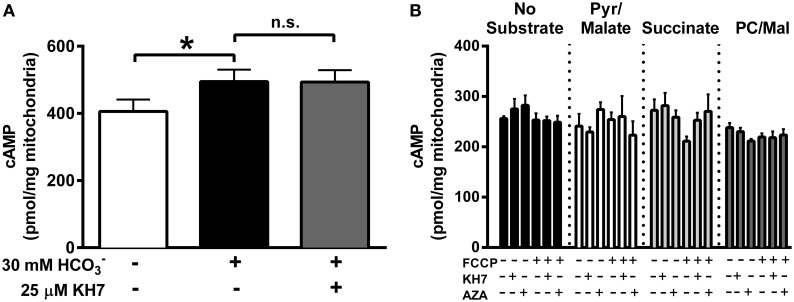
TCA-cycle dependent flux does not increase mitochondrial cAMP. (A) cAMP was measured in isolated liver mitochondria in the presence of 1 mM ATP, and in the absence of inhibitors (white bar), the presence of 30 mM HCO3- (black bar) or the presence of both HCO3- and 25 μM KH7 (gray bar). N = 4/condition. * denotes p < 0.05 compared to untreated condition. (B) cAMP was measured in isolated skeletal muscle mitochondria in the presence of 1 mM ATP, and in the absence (black bars) of respiratory substrates or in the presence of pyruvate/malate (white bars), succinate (light gray bars) or palmitoyl-L-carnitine/malate (dark gray bars). For each round of experiments, a single mitochondrial preparation was used for all substrate conditions, including parallel experiments with FCCP, KH7, and acetazolamide (AZA). N = 4 mitochondrial preparations from individual mice.